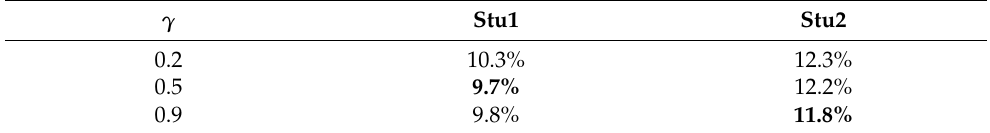
Table 5. The effect of γ in MKD when p =